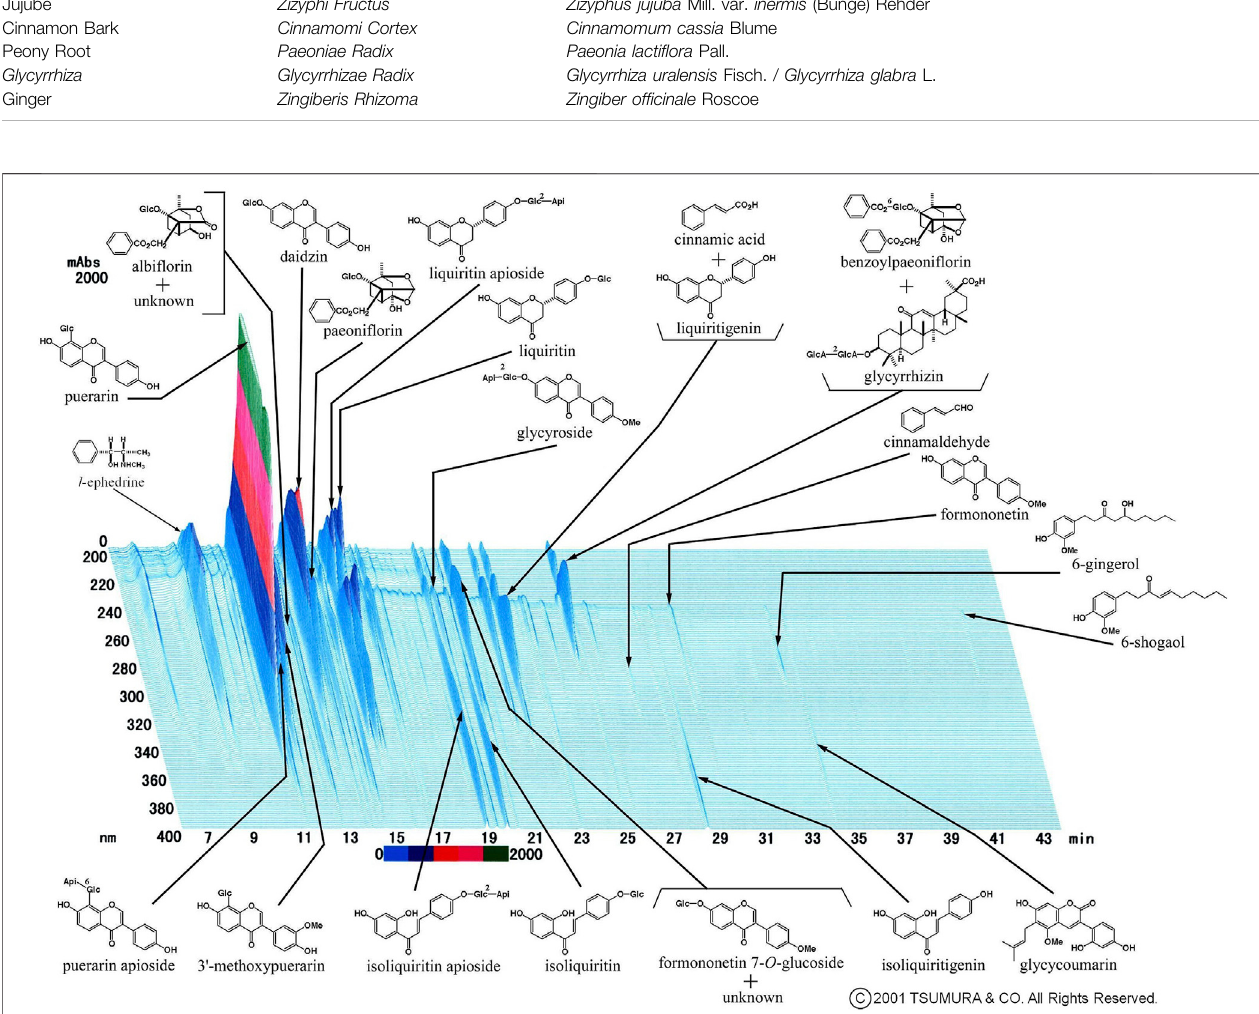
FIGURE 1 | Representative 3D-HPLC image of kakkonto extract. Kakkonto contains ephedrine from Ephedra Herba , puerarin or daidzin from Puerariae Radix , paeoni fl orin from Paeoniae Radix , cinnamic acid from Cinnamomi Cortex , and glycyrrhizin or liquiritin from Glycyrrhizae Radix .